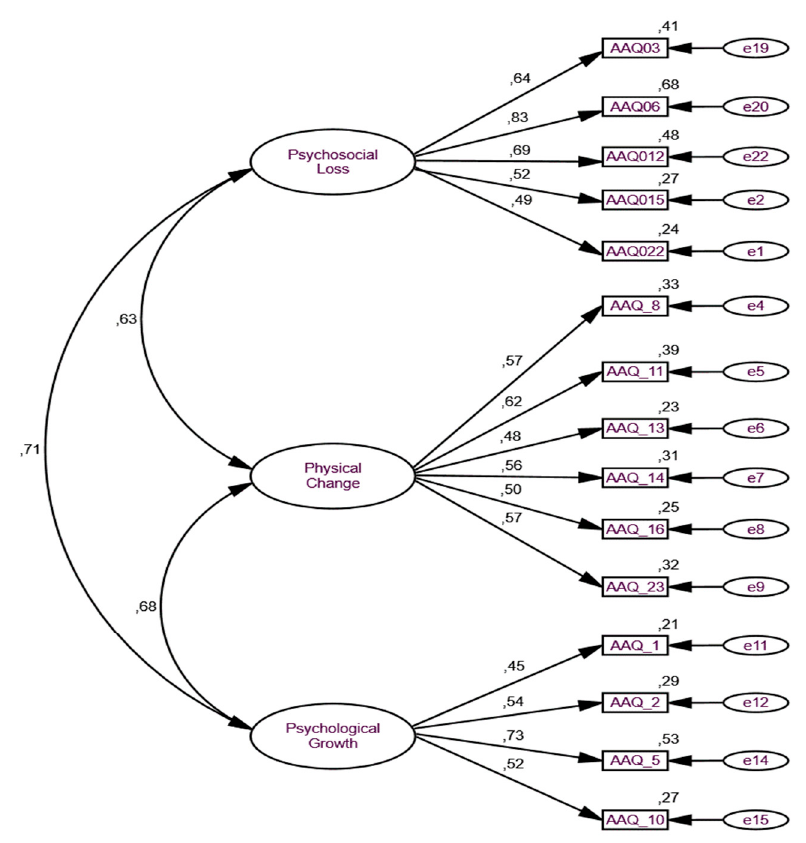
Figure 2. CFA of the re-specified 3-factorial AAQp.